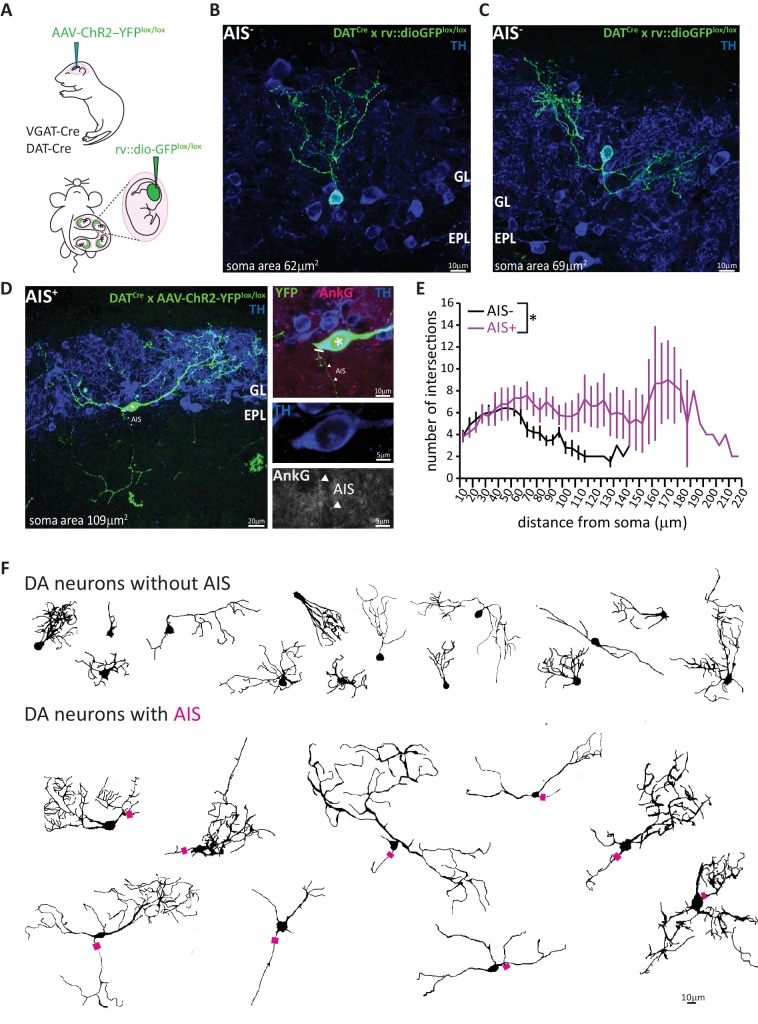
AIS-positive DA cells have more widely ramified dendritic morphology.(A) Schematic representation of the experimental strategy adopted to achieve sparse labelling of DA cells: P1-2 neonates or E12 embryos from VGAT-Cre or DAT-Cre lines were injected with floxed AAV-YFP or rv:: dio-GFP viruses. Tissue was collected for analysis at P28. (B–C) Example images of OB DA cells sparsely labelled with GFP (green), co-stained for TH (blue). GL, glomerular layer; EPL, external plexiform layer. AIS-negative DA cells ramify their dendrites narrowly. (D) Example image of a GFP-labelled, AIS-positive DA cell which ramifies more broadly, co-stained for TH (blue) and AnkG (magenta). Right: zoomed insets showing GFP, TH and/or AnkG label; line indicates axon start; triangles show AIS start and end positions. (E) Sholl plots of branching patterns for reconstructed DA neurons without (black, n = 14) and with (magenta, n = 9) an AIS. Data points are mean ± SEM; effect of cell type in mixed model ANOVA; *p<0.05; for further quantifications see Table 1. (F) Morphological reconstructions of 23 sufficiently sparsely-labelled DA neurons without (top) and with (bottom) an AIS. Approximate AIS location is indicated with a magenta square.